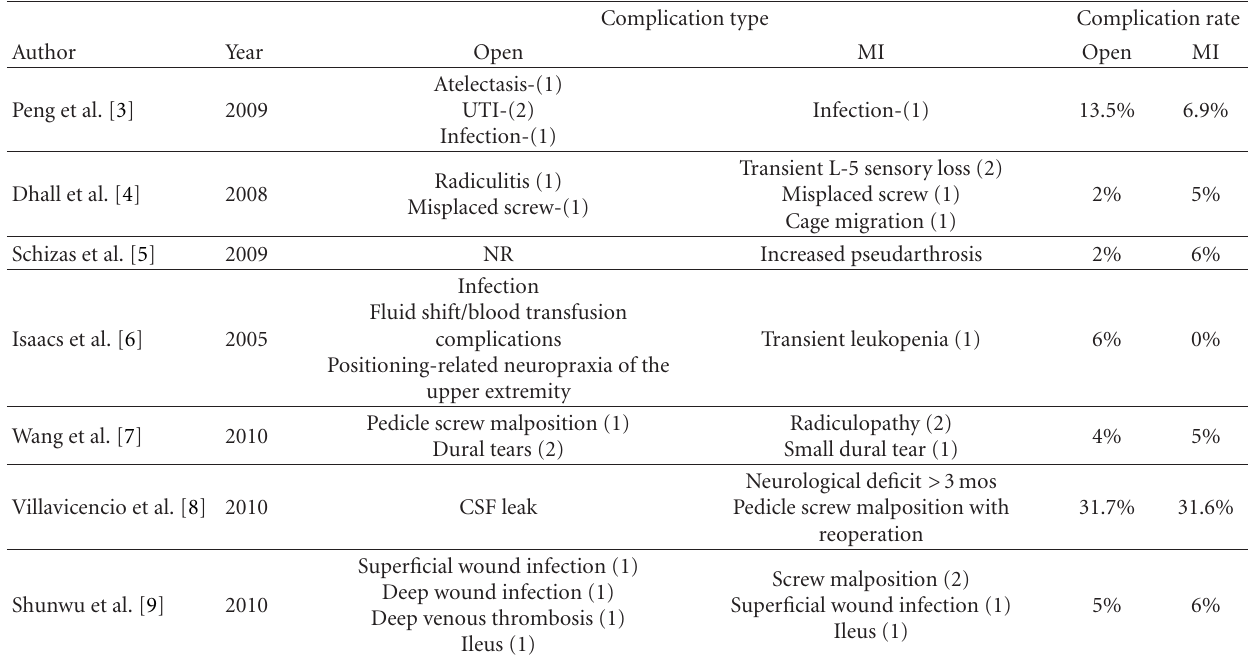
Table 3: Complications found in studies comparing open TLIF to MI-TLIF.